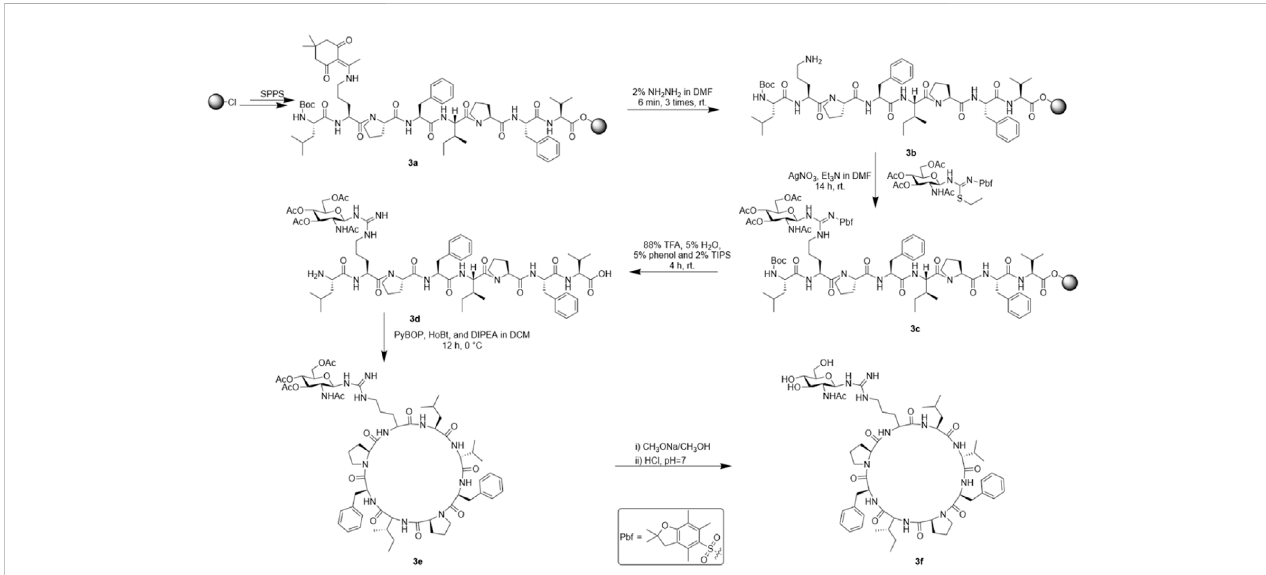
FIGURE 7 Synthesis route of SA-HH-TT.